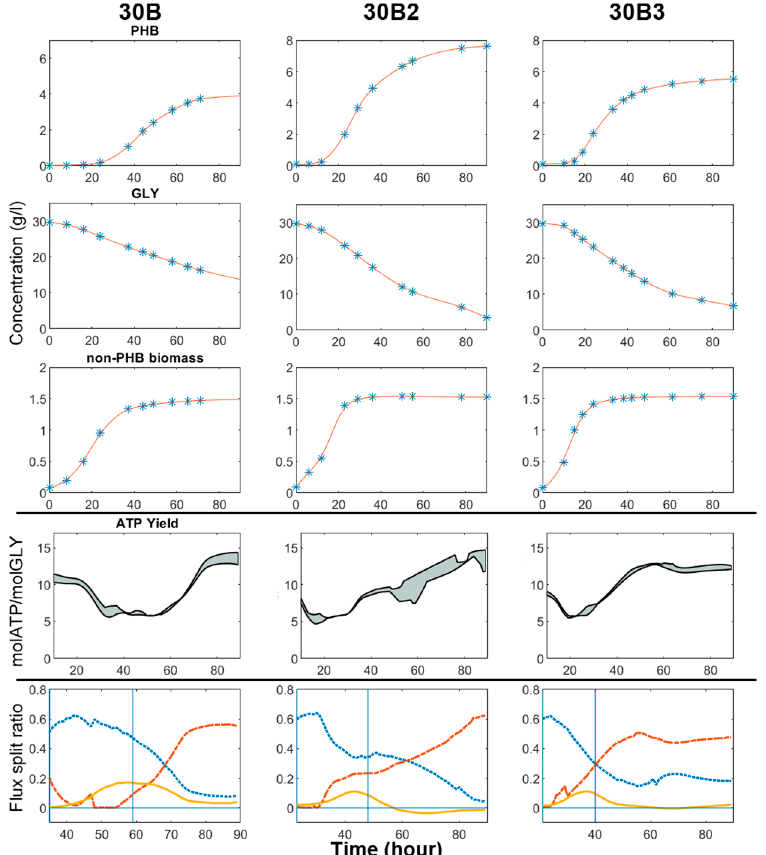
Figure 10. Results summary of the three bioreactor batch experiments with 30 g / L of glycerol. Profiles of metabolite concentrations (PHB, glycerol and non-PHB biomass), ATP yield and carbon split ratio were shown.